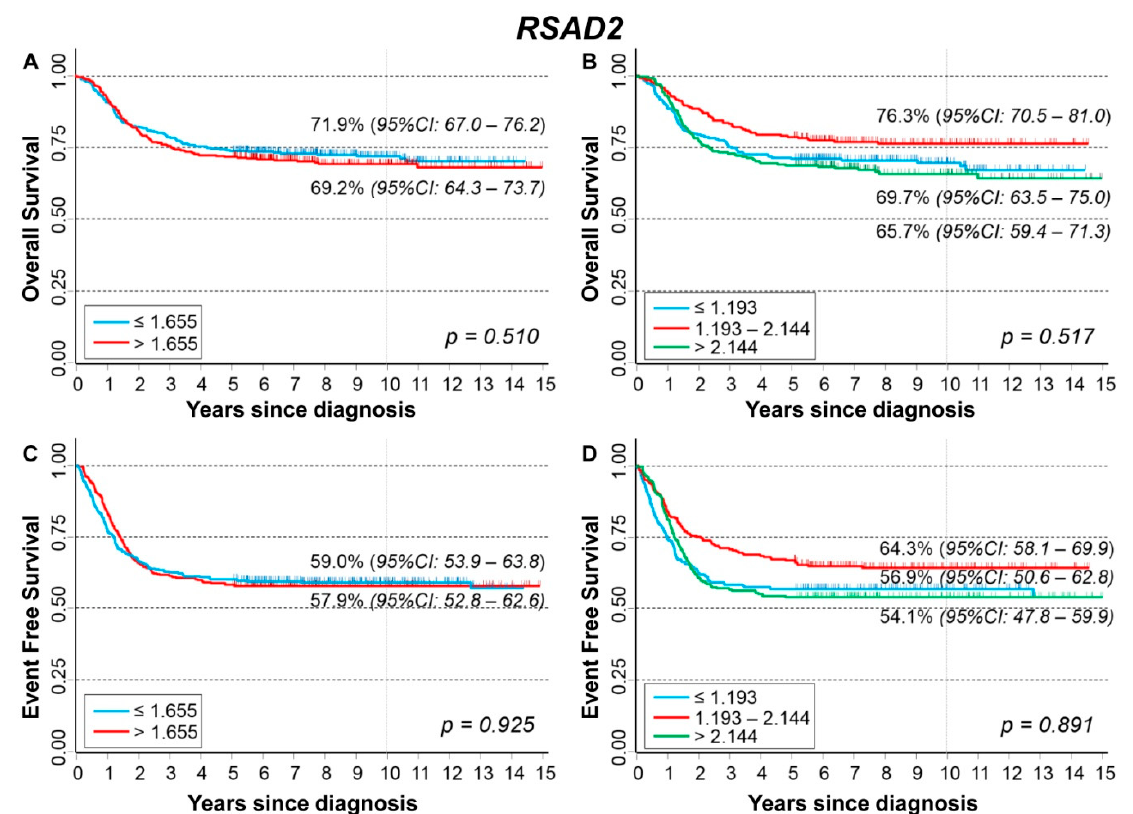
Figure 13. Patient Survival in relation to RSAD2 expression level. Overall Survival of 786 NB patients with ( A ) cut-off based on the median expression value or ( B ) on tertile expression values. Event Free Survival of 769 NB patients with ( C ) cut-off based on the median expression value or ( D ) on tertile expression values. Ten-year survival estimates are displayed. Table 12. Overall Survival of 786 NB patients in relation to RSAD2 expression levels evaluated by the Cox model. Univariable Analysis